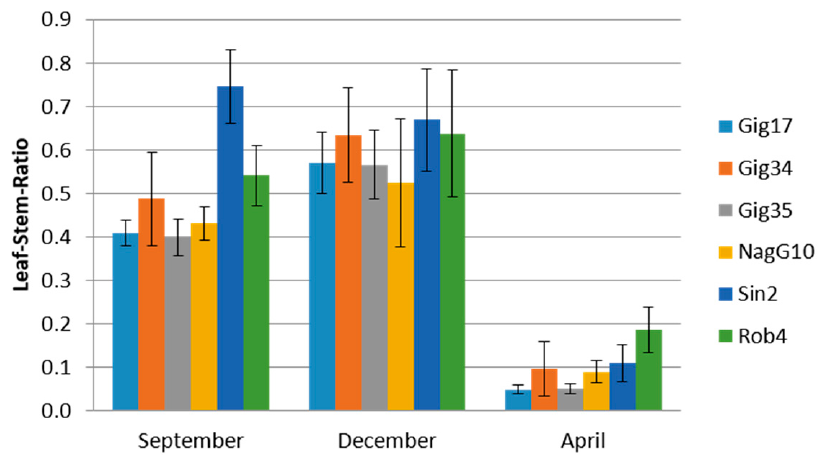
Figure 11. Leaf versus stem content of Miscanthus genotypes: M. x giganteus (Gig17, Gig34, Gig35), M. nagara (NagG10), M. sinensis (Sin2), and M. robustus (Rob4), harvested in September, December, and April, respectively (arranged to follow the seasonal order from autumn to spring). Reprinted from [27] under open access license.